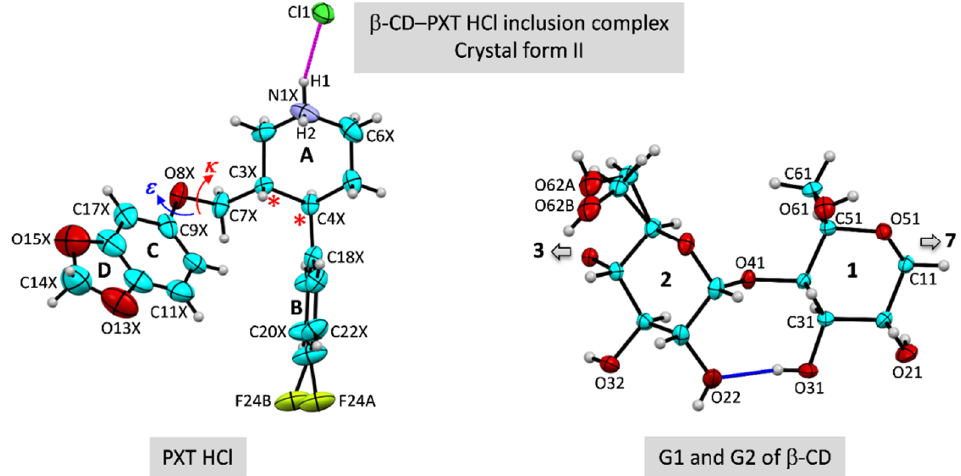
Figure 1. Atom numbering schemes of (3 S ,4 R )-PXT HCl and β -CD in crystal form II of the β -CD–PXT HCl complex; ORTEP plot at 30% probability level. The PXT molecule is protonated at the N1X axial position (H2) and counterbalanced, equatorially coordinated (H1) by a fully occupied chloride . The chiral centers C3X and C4X in the A-ring are red starred. The connecting blue and magenta lines respectively indicate the intramolecular, interglucose O3 ( n )∙∙∙ O2 ( n + 1 ) hydrogen bonds stabilizing the round β - CD conformation and the intermolecular N1X–H1 ∙∙∙ Cl1 H-bond in PXT HCl.